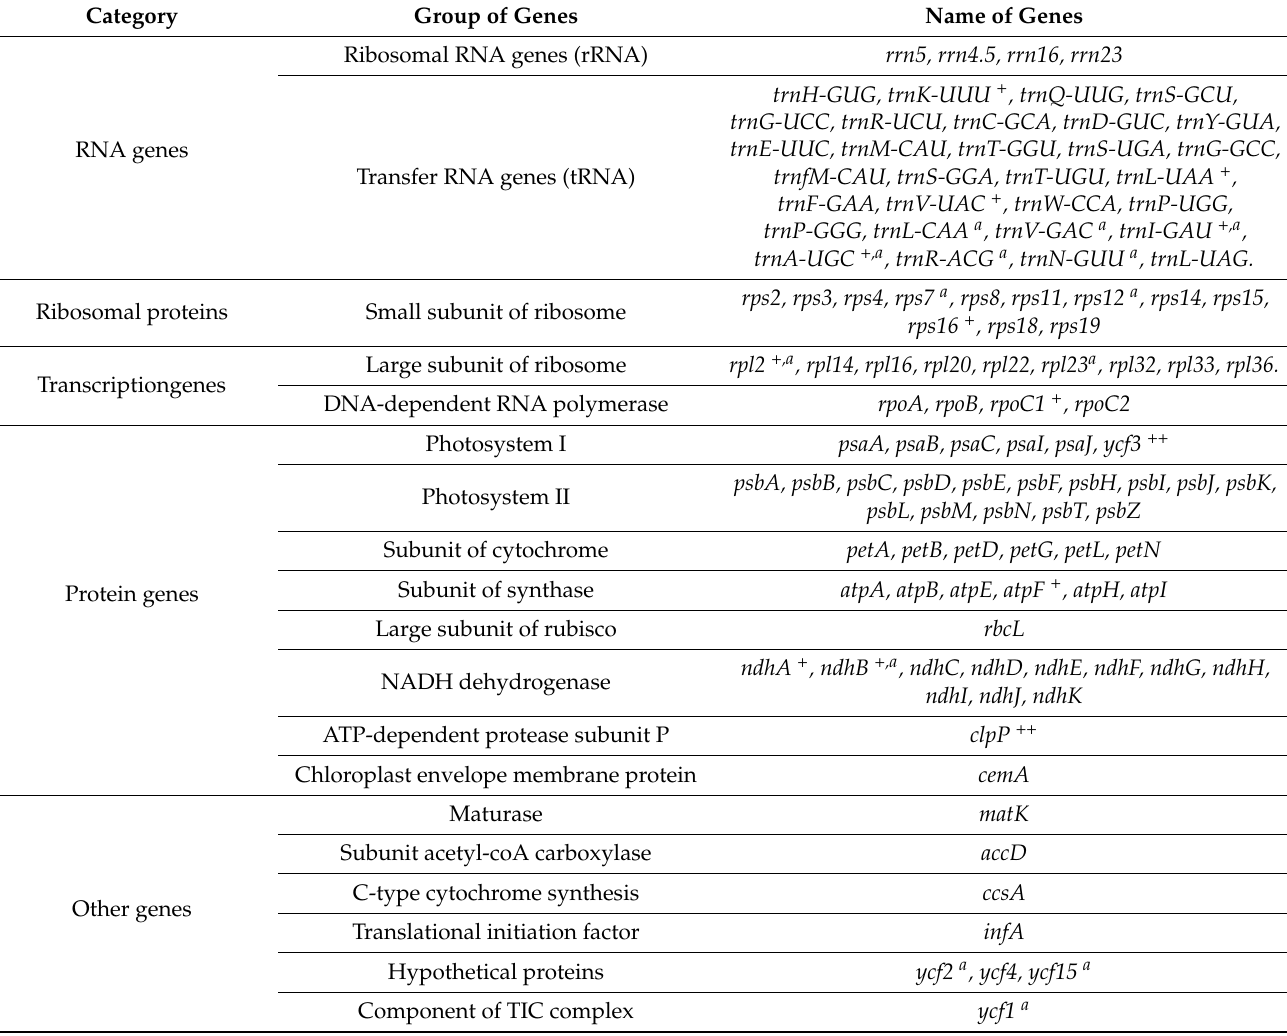
Table 2. Genes present in the chloroplast genome of A. fruticosum